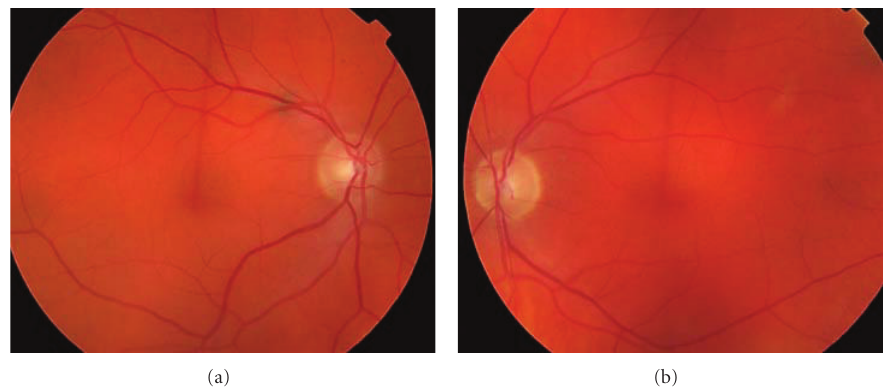
Figure 1: Fundal examination reveals a pale left optic nerve.